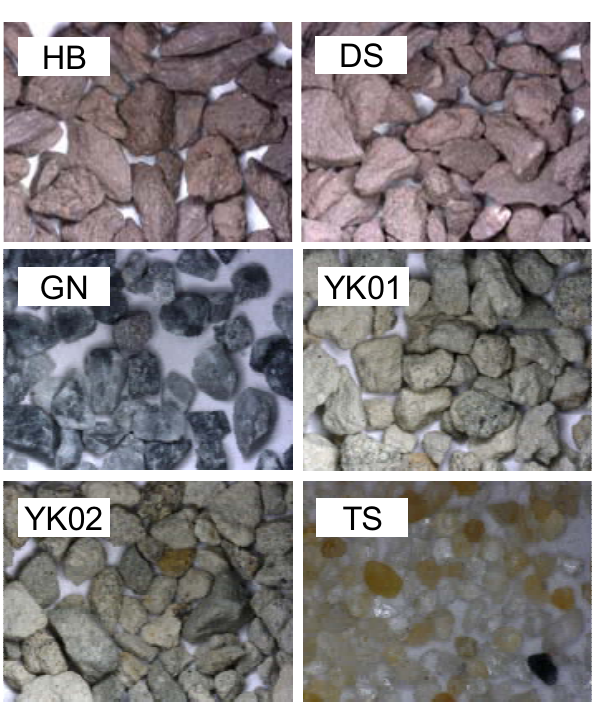
Fig. 4. Microscopic view of all crushed rocks (2.0–0.84mm) and Toyoura sand Figure 4. Microscopic view of all crushed rocks (2.0-0.84mm) and Toyoura sand grains. 3